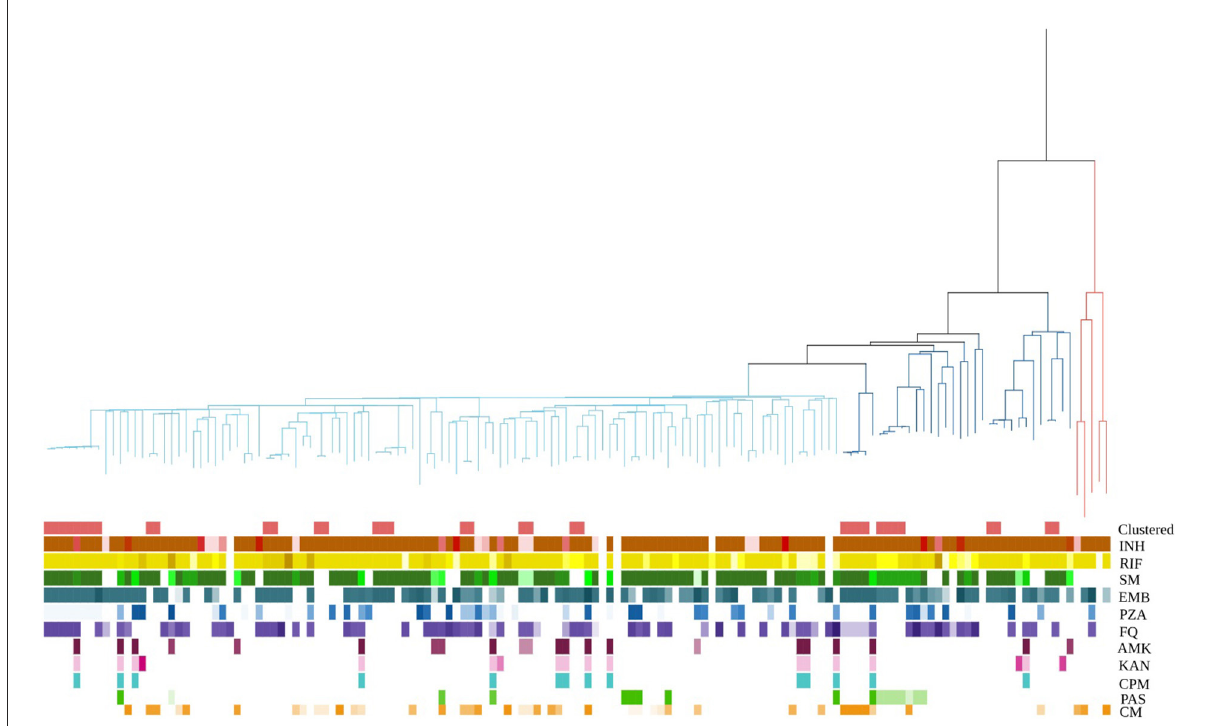
FIGURE2 MDR-MTBC phylogeny and resistance mutations of isolates. First row showed whether it is clustered. Others show drug resistance associated mutations to first-line and second-line drugs (different mutations represented by different colors), and putative compensatory mutations in the RNA polymerase genes rpoA, rpoB and rpoC. MTBC lineage are differentiated into three clades. Red, blue, and cyan branches indicated lineage 4, ancient Beijing, and modern Beijing strains, respectively. INH, isoniazid; RIF, rifampicin; SM, streptomycin; EMB, ethambutol; Z PZA, pyrazinamide; FQ, fluoroquinolone; AMK, amikacin; KAN, kanamycin; CPM, capreomycin; PAS, para aminosalicylic acid; CM, compensatory mutations.